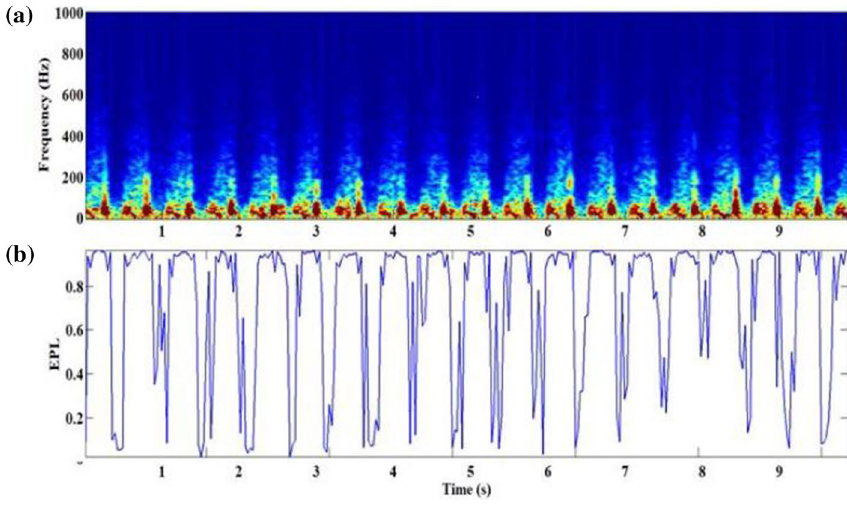
Figure 5. ( a ) The spectrogram of heart sounds from the subjects with VSD, and ( b ) the product of global attention and local attention